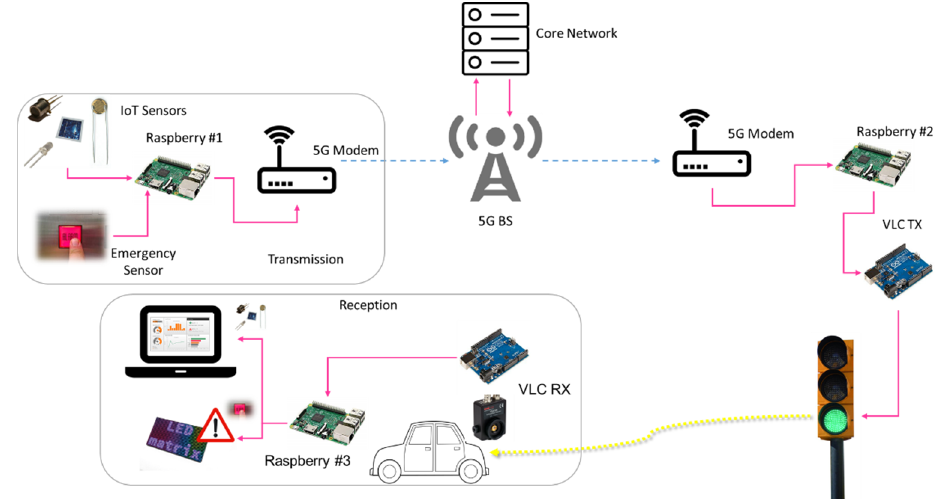
Figure 4. Test-bed architecture of the 5G-VLC joint network.